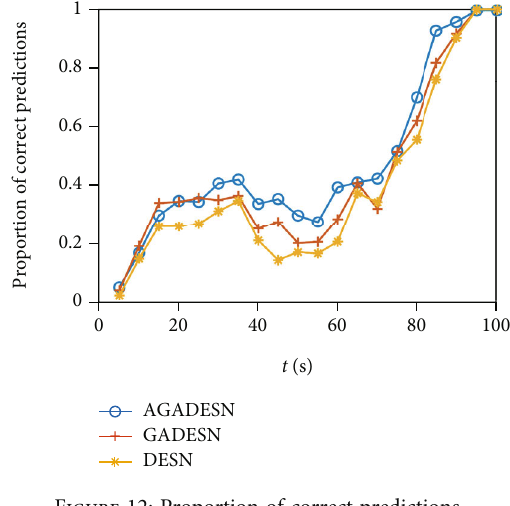
Figure 10: Destination position prediction RMSE of the cluster in Figure 7.